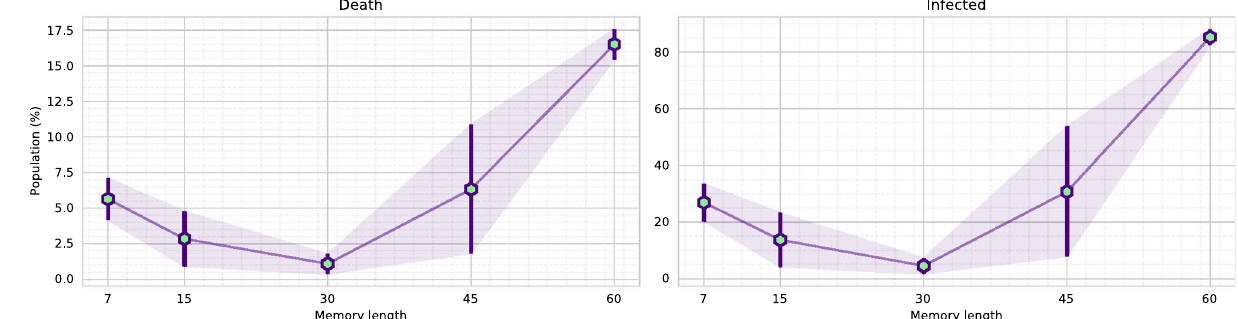
Figure 11. The graphs represent the average deaths and infections caused while an agent performed actions. The results are presented in mean value with standard deviation error. It is also guaranteed that every model is tested in the same environment